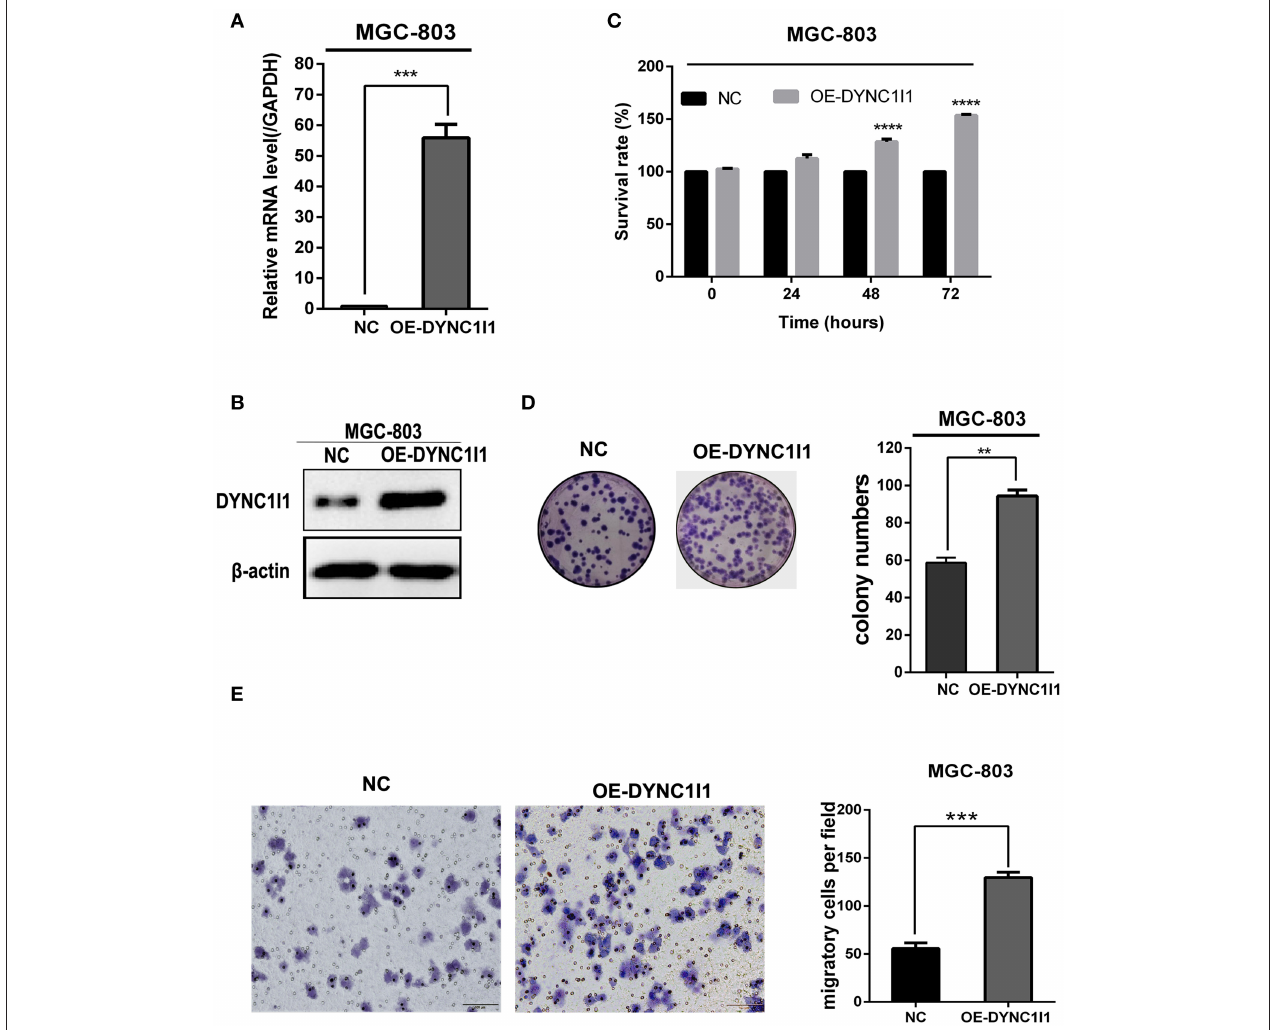
FIGURE 3 | Overexpression of DYNC1I1 promotes cell growth and migration of gastric cancer cells in vitro. (A,B) RT-qPCR and Western blot were used to detect DYNC1I1 expression in MGC-803. (C) MTT shows cell viability of gastric cancer cells after overexpressing DYNC1I1 for 0, 24, 48, 72, 96h. (D) Transwell migration assay of MGC-803 with DYNC1I1 overexpression. Original magnification, x200. Scale bar: 100 µ M. β -actin was used as a loading control in Western blot. (** P < 0.01, *** P < 0.001, **** P < 0.0001, n = 3, student t -test, means ± 95% CI).